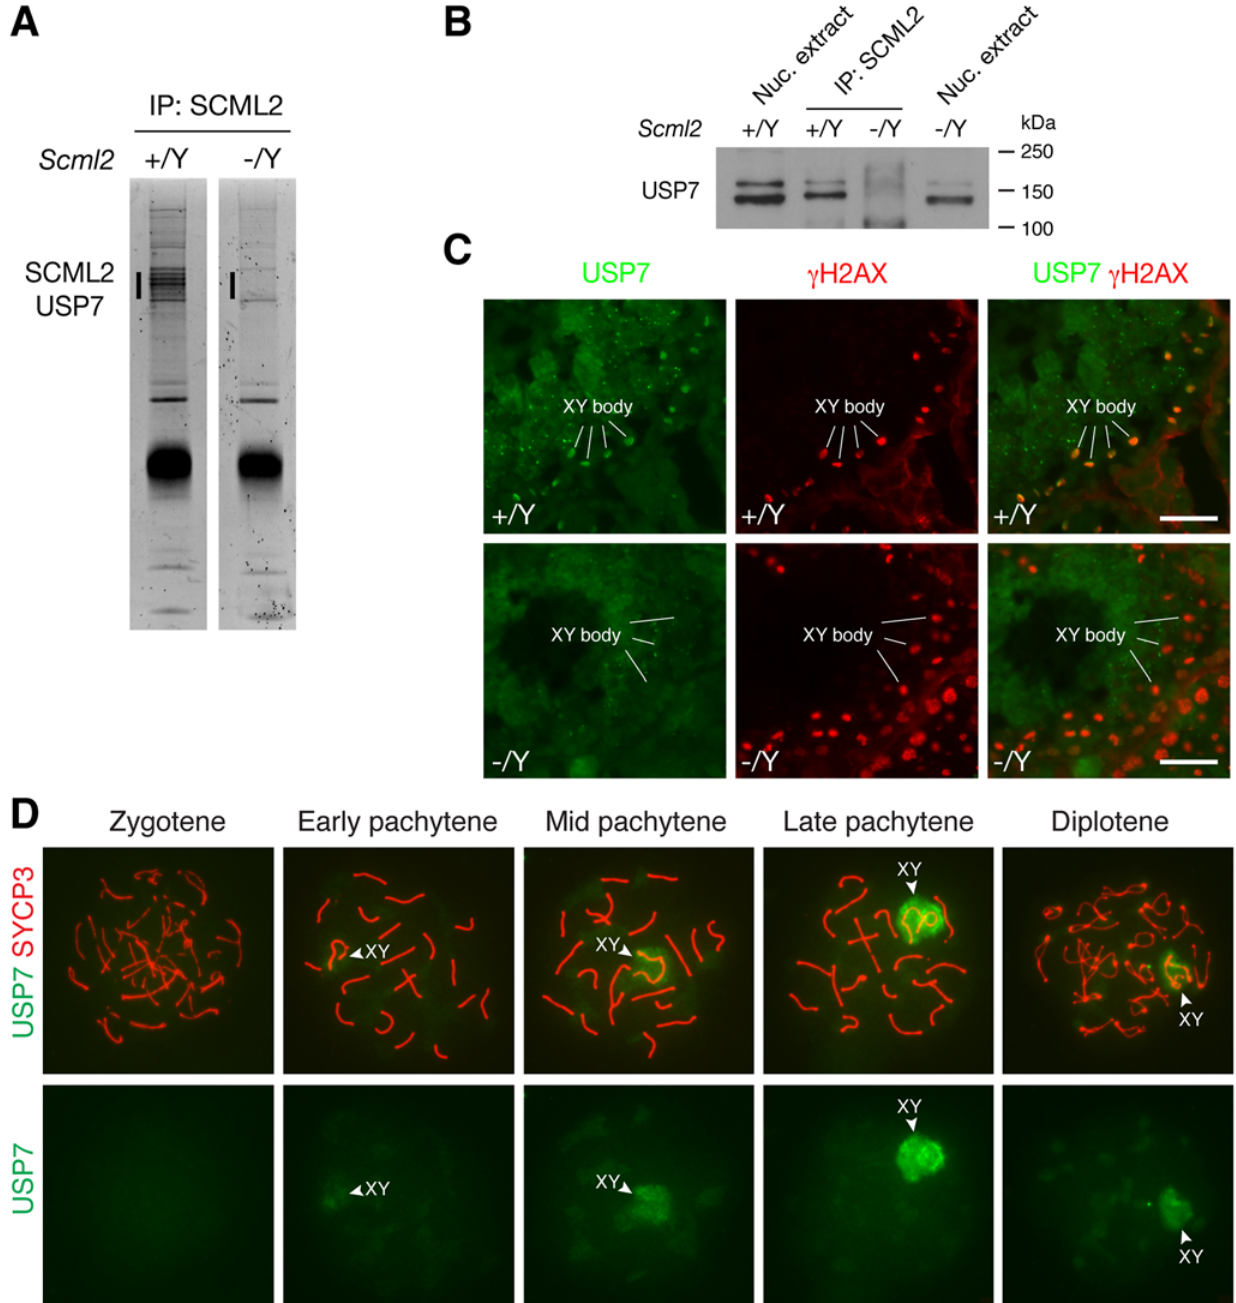
Figure 4. SCML2 associates with USP7 in the XY body. (A) Identification of SCML2-associated proteins from 20-day testes by immunoprecipitation (IP) and mass spectrometry. The extra bands (vertical line) in the wild type IP and the corresponding region (vertical line) in the Scml2 -/Y IP were subjected to mass spectrometry. (B) Co-immunoprecipitation of SCML2 with USP7 in testes. Nuclear protein extracts prepared from 20-day testes were used. Scml2 -/Y testes were used as a negative control. Note that the USP7 antibody (Bethyl Laboratory) recognizes two bands with the lower band being more abundant. Both USP7 bands were co-immunoprecipitated with SCML2. However, the nature of the two USP7 isoforms is unknown. (C) Immunolocalization of USP7 and γ H2AX in wild type and Scml2 -/Y seminiferous tubules from 8-week-old mice. Testicular frozen sections were used for double immunostaining. Scale bars, 25 μ m. (D) Localization of USP7 to the XY body in wild type spermatocytes. Spread nuclei from prophase I spermatocytes (from zygotene to diplotene stages) were immunostained with anti-USP7 and anti-SYCP3 antibodies. USP7 localization alone is shown in bottom panels.